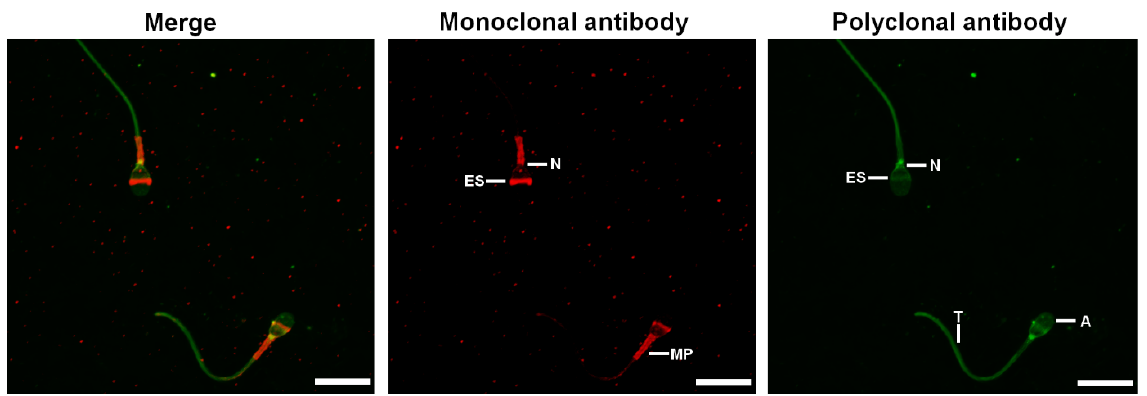
Figure 3. Double immunofluorescence with the two anti-HSP70 antibodies. Purified human spermatozoa were incubated in a capacitating medium for 4 h. They were then fixed with 4% paraformaldehyde, permeabilized with 0.3% Triton-X-100 and stained successively with polyclonal (Proteintech, 10995-1-AP, green labelling) and monoclonal (Sigma, H5147, red labelling) anti-HSP70 antibodies. Scale bar: 10 μ m. Images are maximum-intensity projections (MaxIP) obtained from z stack images using Nikon NIS Elements software. A: acrosome, ES: equatorial segment, MP: mid-piece, N: neck, and T: tail.